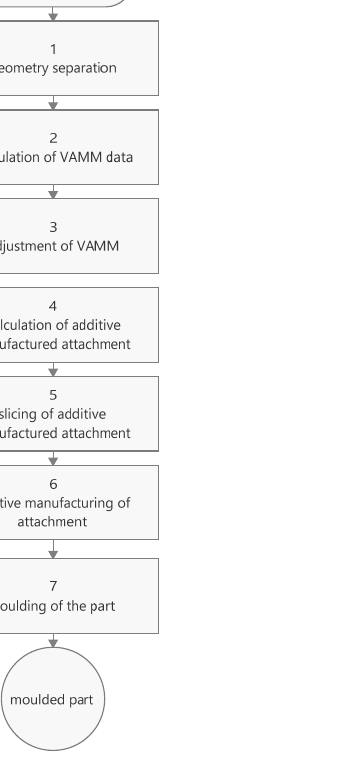
Figure 7. Process flow chart for enhanced vacuum assisted multipoint moulding with additive attachments.